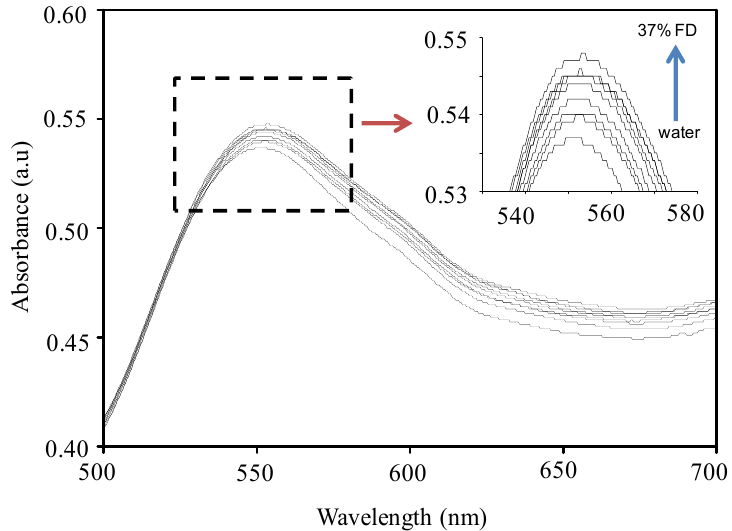
Figure 5. Absorption spectra of GNS in the presence of several concentration of FD. The absorbance of the GNS increase and the plasmonic peaks red-shift with the increasing of the FD